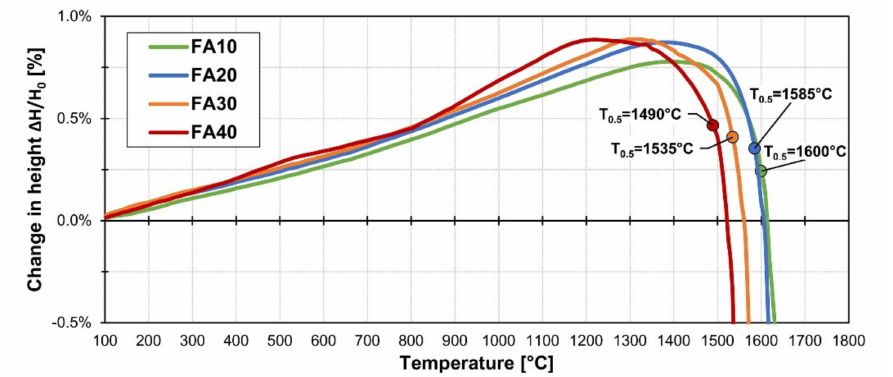
Figure 9. Results of refractoriness under load of mixtures with fly